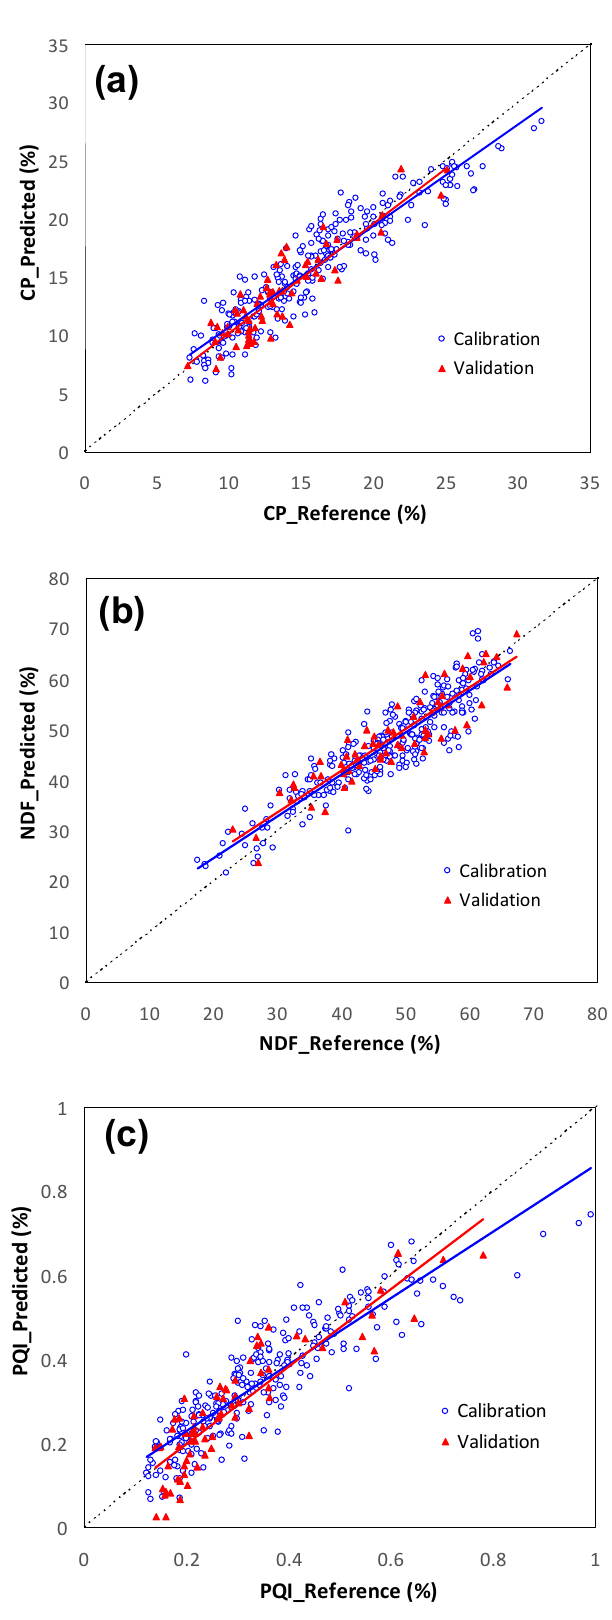
Figure 5. Plot of reference values versus predicted values for calibration and validation phases: ( a ) CP, ( b ) NDF, and ( c ) the PQI.